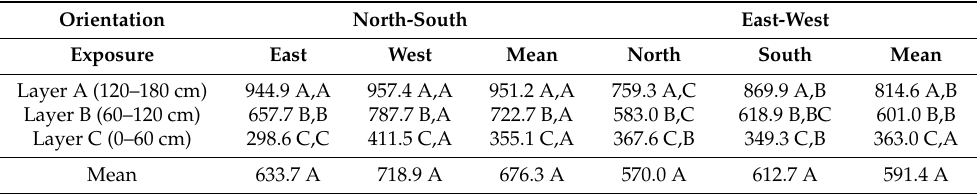
Table 6. Mean PAR ( μmol photons m − 2 s − 1 ) in the canopy. The first letters denote significant differences between layers for a given exposure; the second letters denote significant differences between exposures for a given layer (SNK test). Lower case letters denote statistical differences with p = 0.05. Capital letters denote statistical differences with p = 0.01.